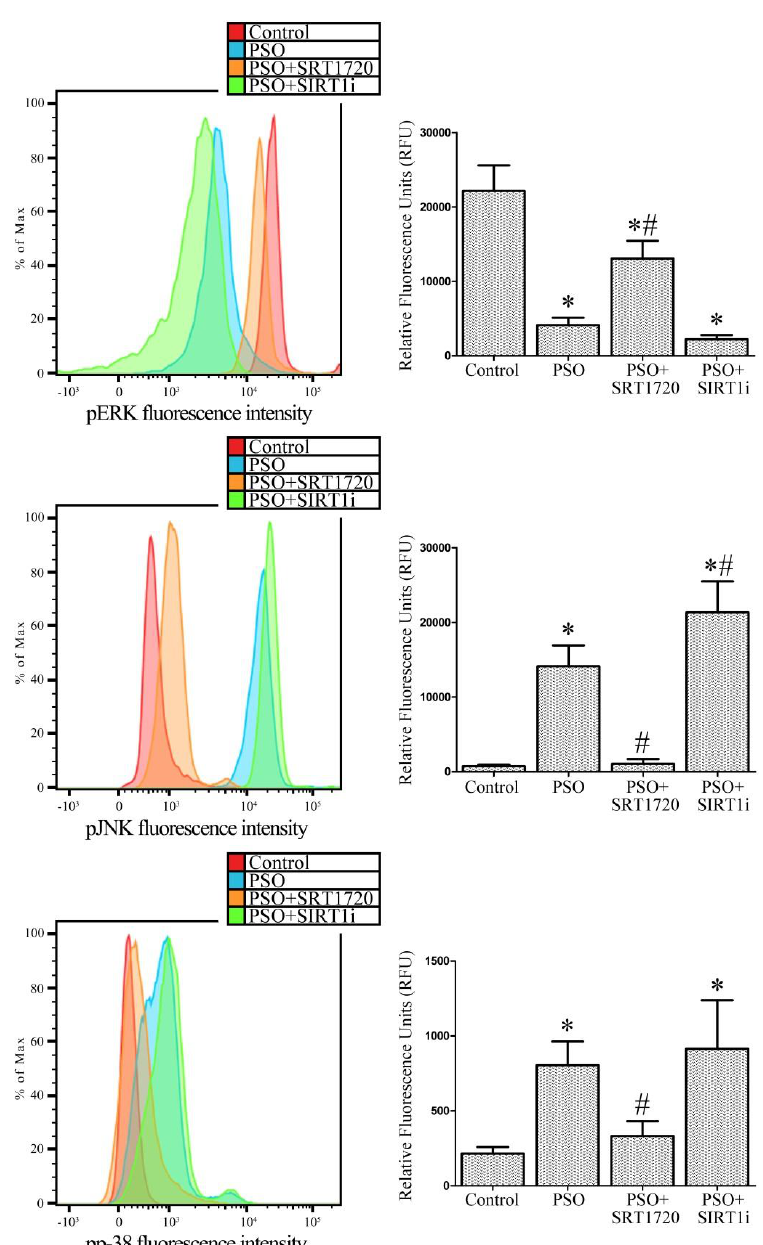
Figure 7. MAPK phosphorylation in fibroblasts from controls ( n = 4 biopsies) and psoriatic patients ( n = 4 biopsies) in the presence of SRT1720 or the SIRT1 inhibitor (SIRT1i). Each experiment was performed in triplicate. * Significant difference ( p ≤ 0.05) vs. fibroblasts from healthy patients. # Significant difference ( p ≤ 0.05) vs. fibroblasts from psoriatic patients.